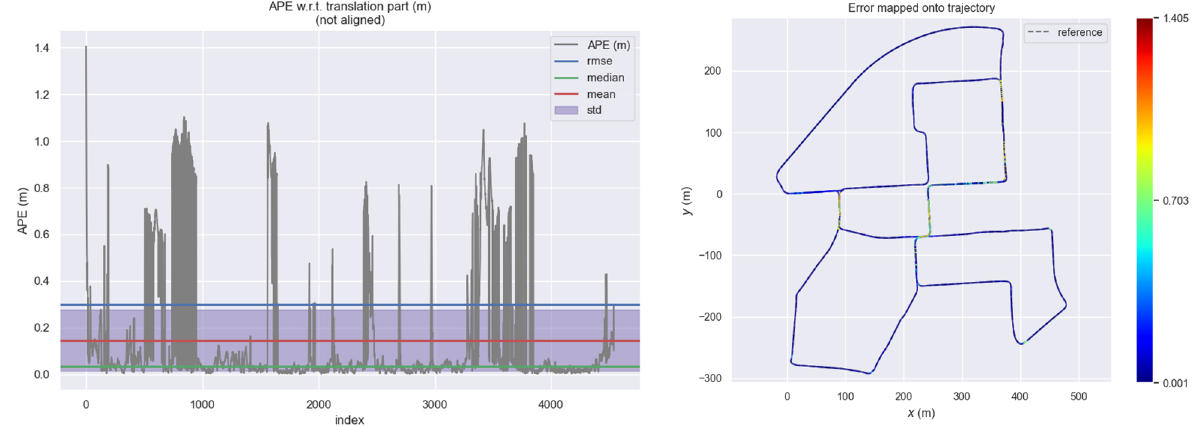
Figure 14. APE result and trajectory of KITTI dataset 00.